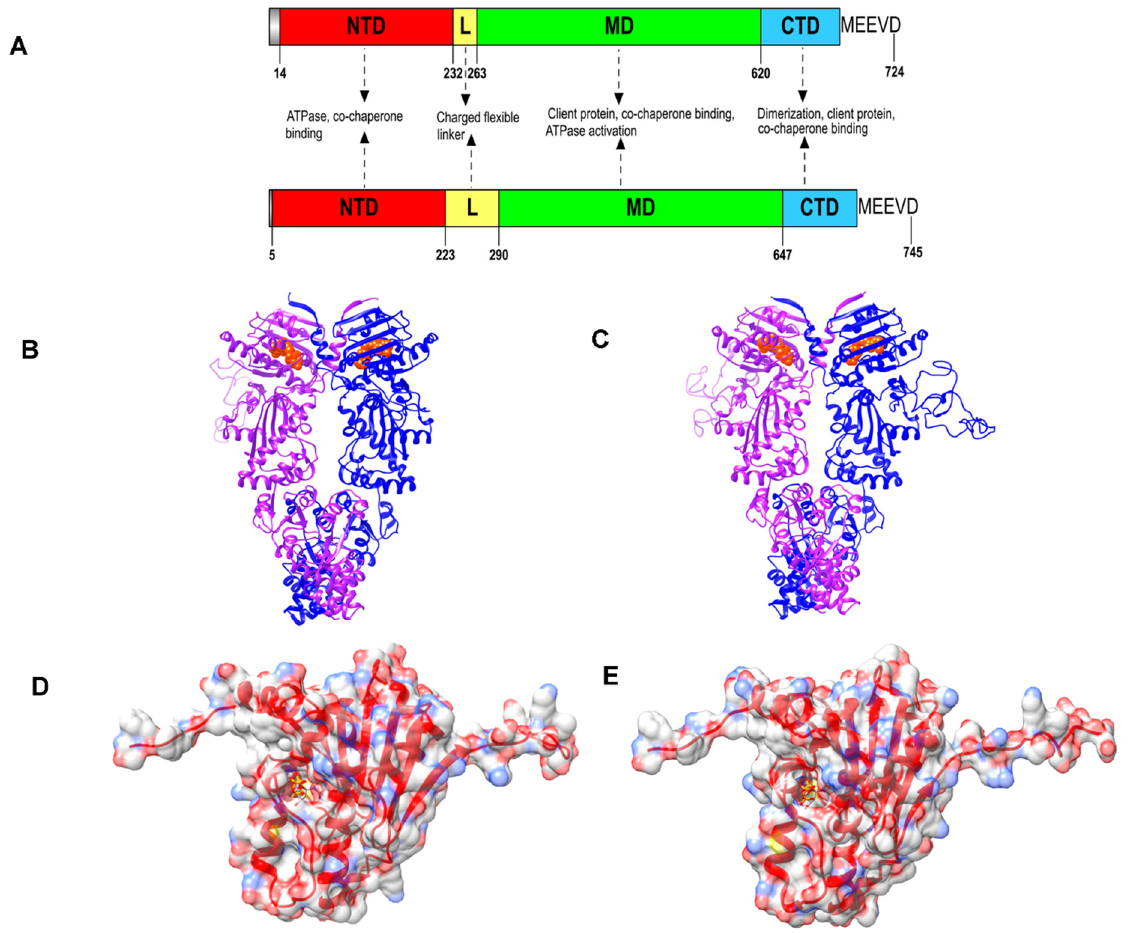
Figure 2. Domain organization and structural view of hHsp90 β and PfHsp90. ( A ). Domain organization of hHsp90 β (top) and PfHsp90 (bottom). Structure of full-length dimeric ( B ). hHsp90 β and ( C ). PfHsp90 proteins as cartoons. ATP bound to the N-terminal domain (NTD) is shown as red spheres. The two Hsp90 monomers in the models are colored purple and blue. ( D ). hHsp90 β and ( E ). PfHsp90 NTD as surface. The surface (with 60% transparency) is colored according to element type and it also depicts the arrangement of secondary structure elements (red color) as cartoons. The bound ATP molecule is represented as sticks, colored according to the element type. Full-length 3D structures of hHsp90 β and PfHsp90 were modeled with SWISS-MODEL (SWISS-MODEL: homology modelling of protein structures and complexes. Available online: https://swissmodel.expasy.org/ [accessed on 12 June 2022]) using PDB files 5FWK and 5FWM, respectively, as templates. NTD: N-terminal domain; L: linker region; MD: middle domain; and CTD: C-terminal domain. Element coloring scheme uses red, blue, grey, and yellow for oxygen, nitrogen, carbon, and phosphorous, respectively. Images for 3D structures were rendered using UCSF Chimera 1.10.1 (UCSF Chimera—a visualization system for exploratory research and analysis. Available online: https://www.cgl.ucsf.edu/chimera/ [accessed on 12 June 2022]), while the linear domain layout image was rendered using IBS 1.0 (IBS: an illustrator for the presentation and visualization of biological sequences. Available online: http://ibs.biocuckoo.org/ [accessed on 12 June 2022]).